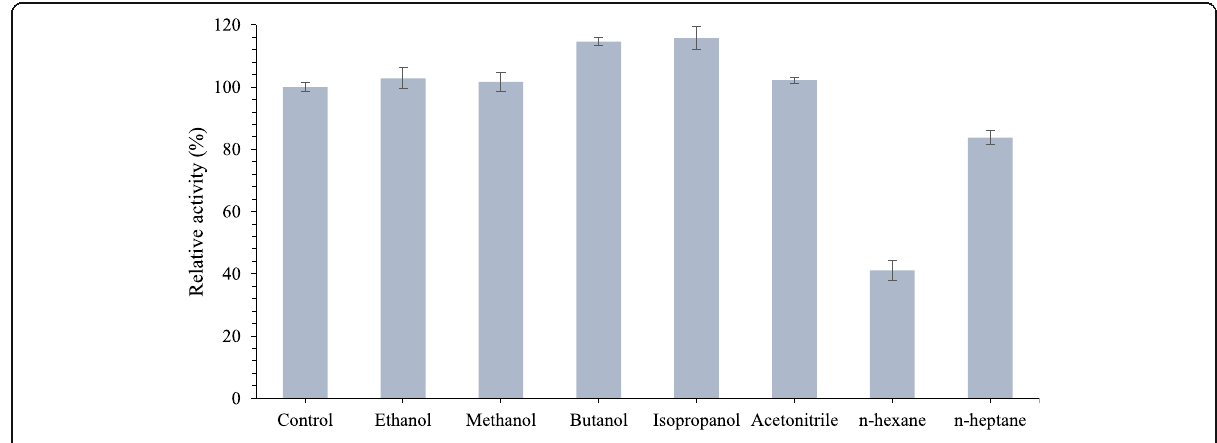
Fig. 4 Effect of organic solvents on LipEMP48-D